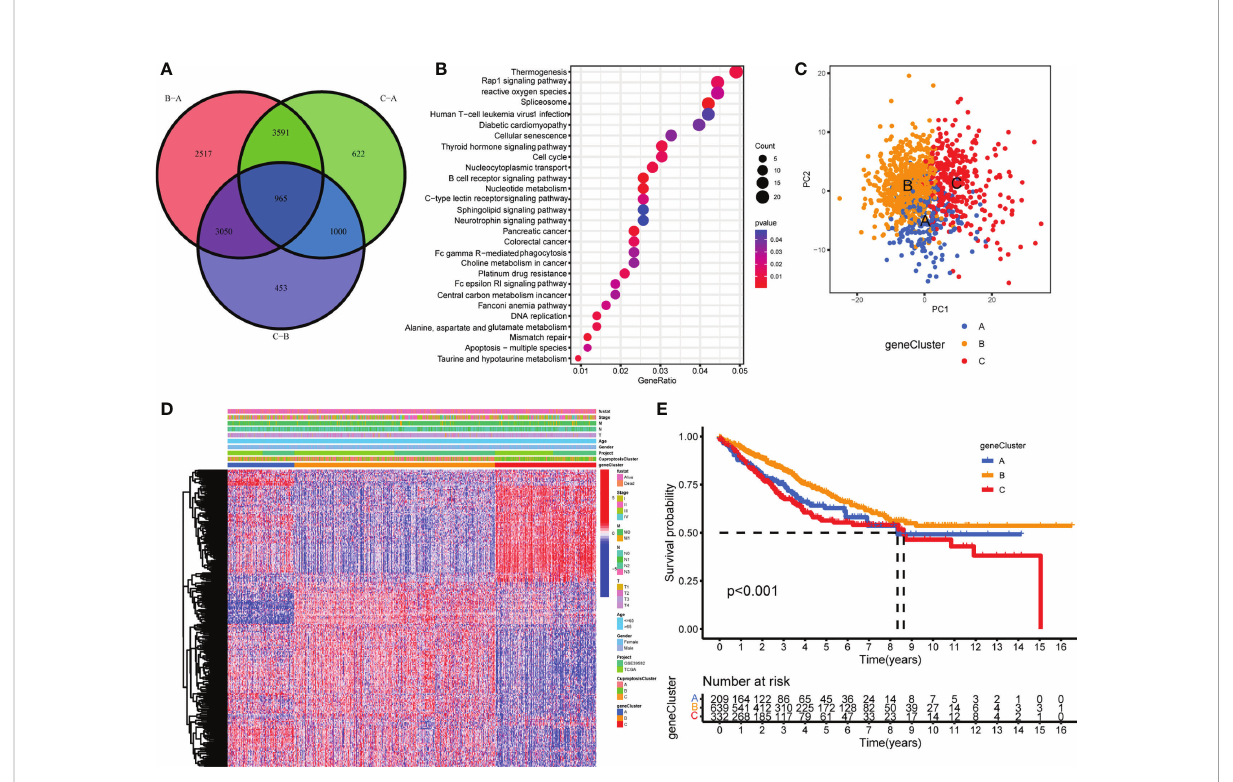
FIGURE 3 Generation of cuproptosis-related geneclusters. (A) The Venn diagram of DEGs between three CuproptosisClusters. (B) KEGG results of 965 DEGs. (C) PCA for three geneClusters to distinguish samples in TCGA COAD/READ and GSE39582. (D) Unsupervised clustering of 260 cuproptosis-related genes. (E) The Kaplan – Meier curves of overall survival between different